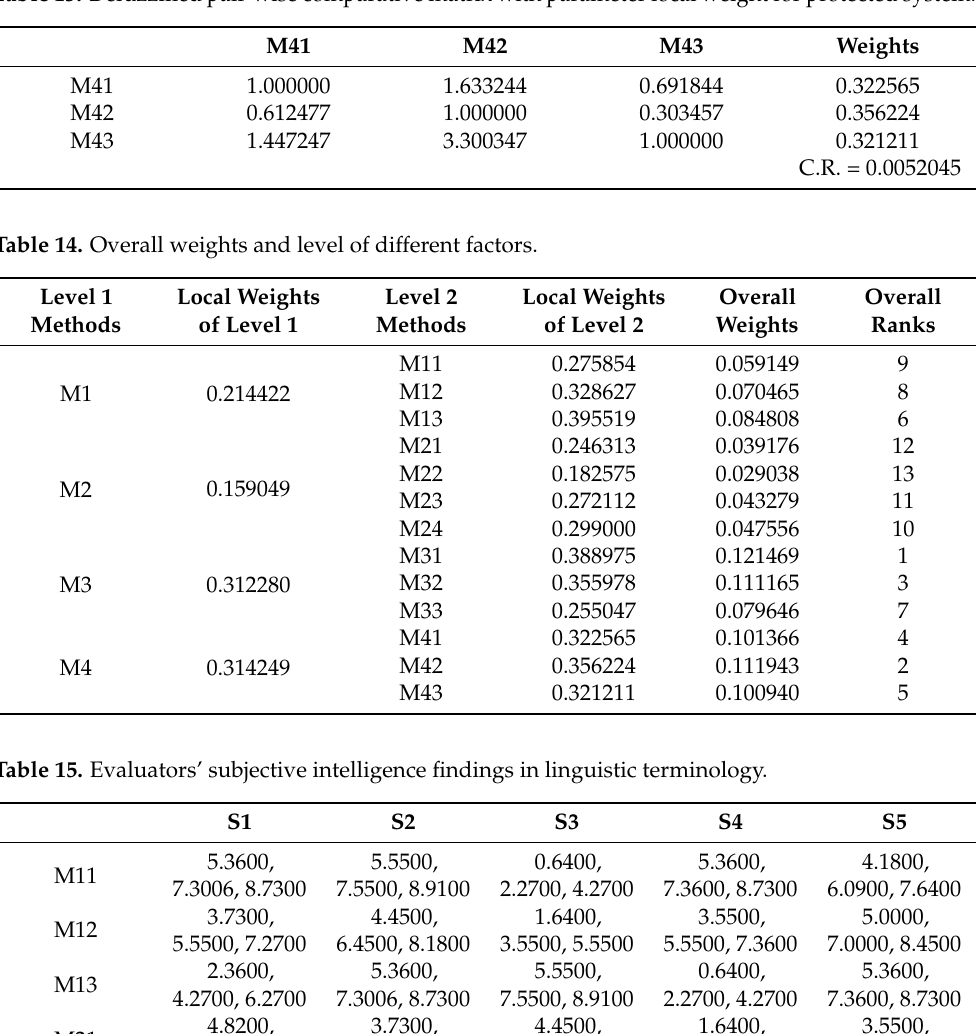
Table 13. Defuzzified pair-wise comparative matrix with parameter local weight for protected system.